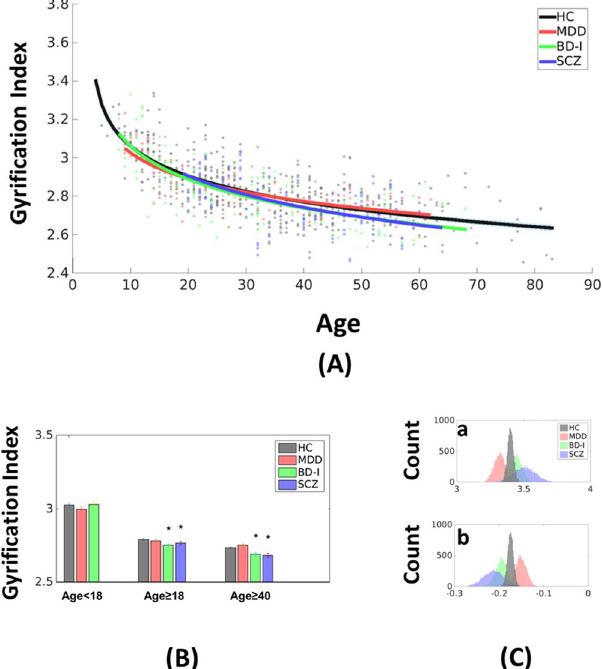
Figure 3. Abnormal gyrification trajectories in patients with major psychiatric disorders. ( A ) Patients with MDD, BD-I and SCZ showed deviated gyrification index (GI) trajectories from the trajectory of healthy subjects. Note that the thin light gray area along the black line indicates the 95% fitting confidence of the healthy trajectory. ( B ) The whole brain GI of healthy subjects and all the psychiatric groups in different age ranges. Patients with bipolar disorder and schizophrenia showed lower GI in the adulthood, especially after the age of 40. ( C ) Resampling results confirmed that the parameters of the fitting function for the GI trajectories of patients with psychiatric disorders were different from that of healthy subjects. Abbreviations: MDD, Major Depressive Disorder; BD-I, Bipolar 1 Disorder; SCZ, Schizophrenia; HC, healthy